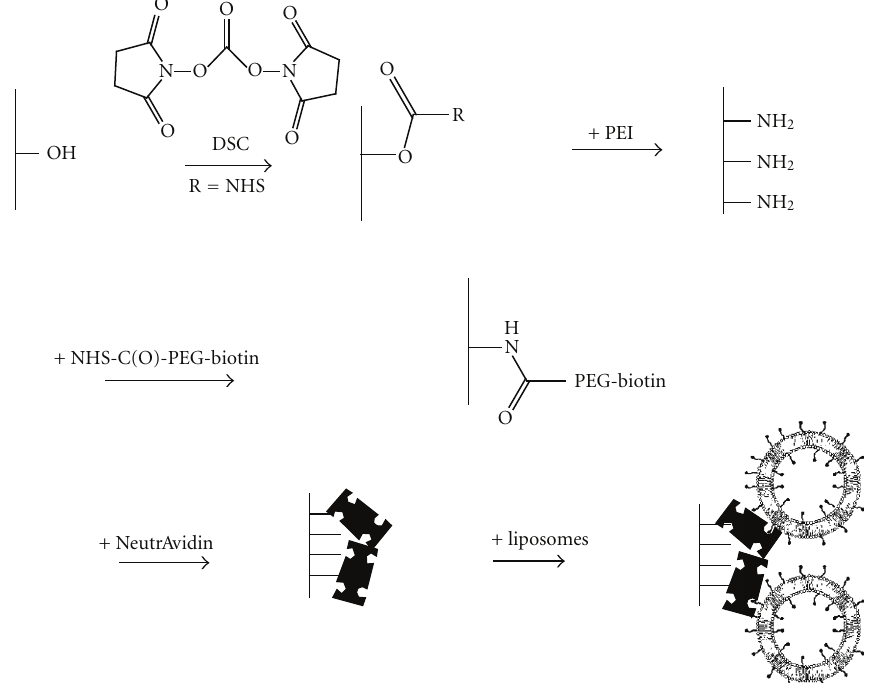
Figure 5: Chemical reactions leading to the attachment of liposomes onto the surfaces of soft contact lenses [32].